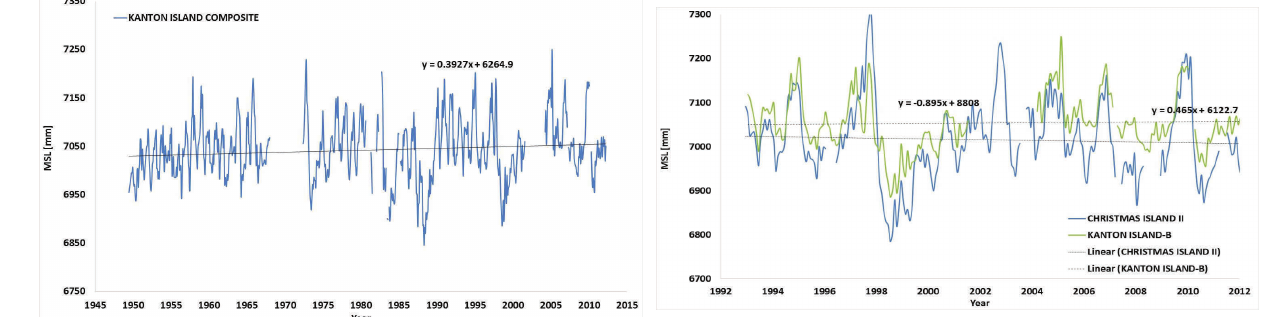
Fig. 6: Comparison of the KANTON ISLAND-B and CHRISTMAS ISLAND II tide gauge results over the same time window (data from